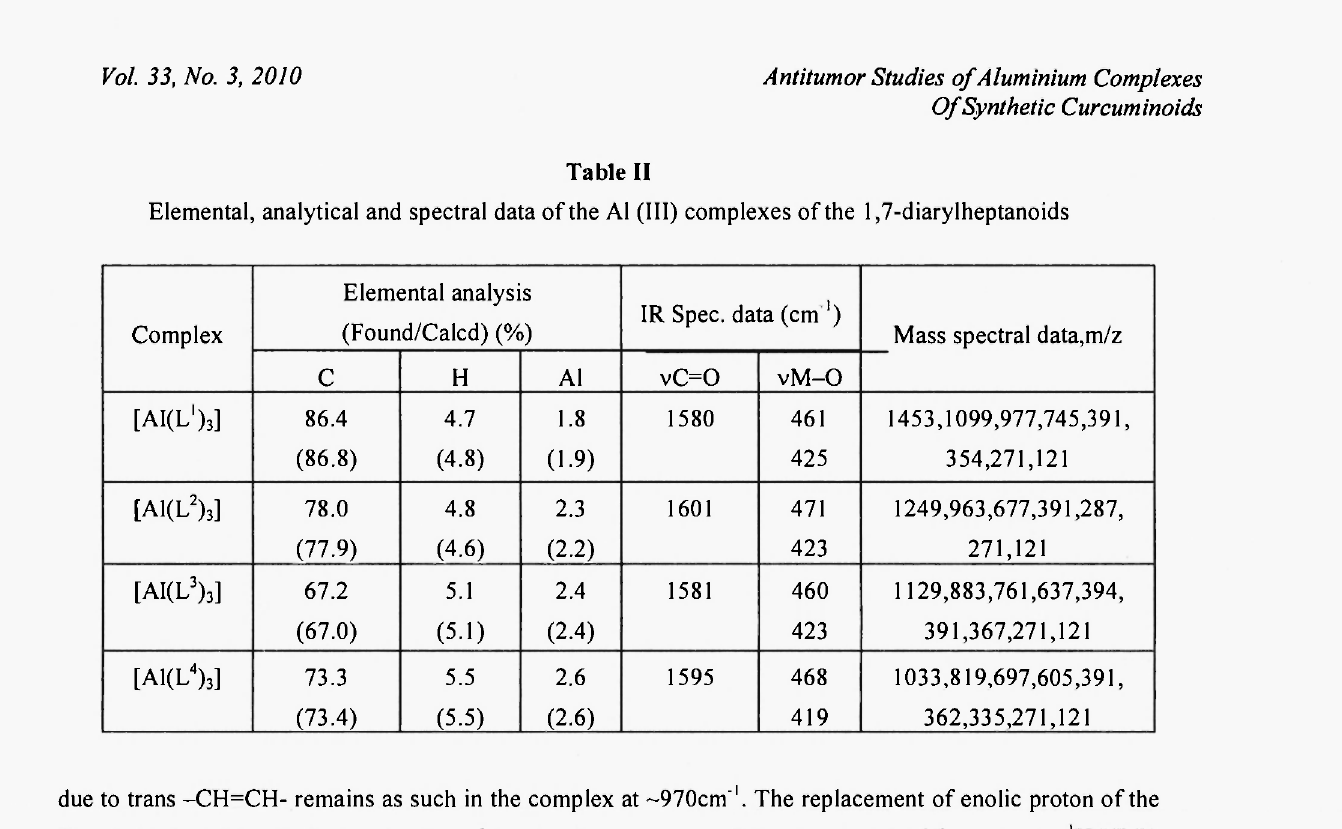
Elemental, analytical and spectral data of the Al (III) complexes of the 1,7-diarylheptanoids